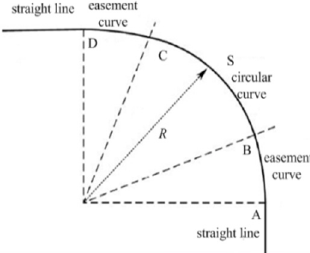
Figure 1. Track curve line plan. A, B, C and D are the four points on the train track. Segment S is a circular curve with a turning radius of R.